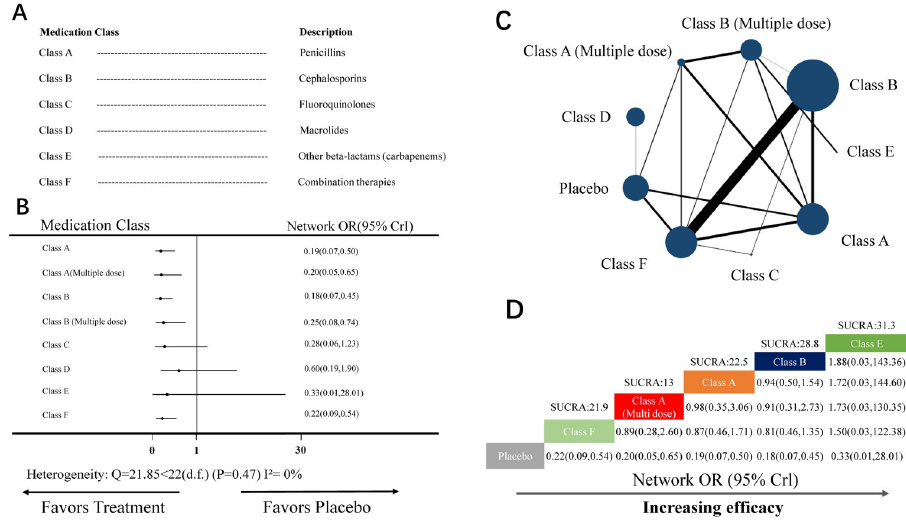
Fig 3. NMA for endometritis. (A) List of the included medication classes. (B) Forest plot of the NMA comparing each intervention against placebo. (C) Each node (blue circles) represents a unique medication class and dosage, and the size of each node represents the number of included women for the intervention. The connecting line indicates the number of direct comparisons between both nodes. The width of each line represents the number of direct comparisons between interventions. (D) Schematic detailing the most efficacious antibiotic class and dosage in NMA for endometritis compared with placebo for surface under the cumulative ranking curve analysis (SUCRA). NMA, network meta-analysis; OR, odds ratio; CrI, credibility interval.